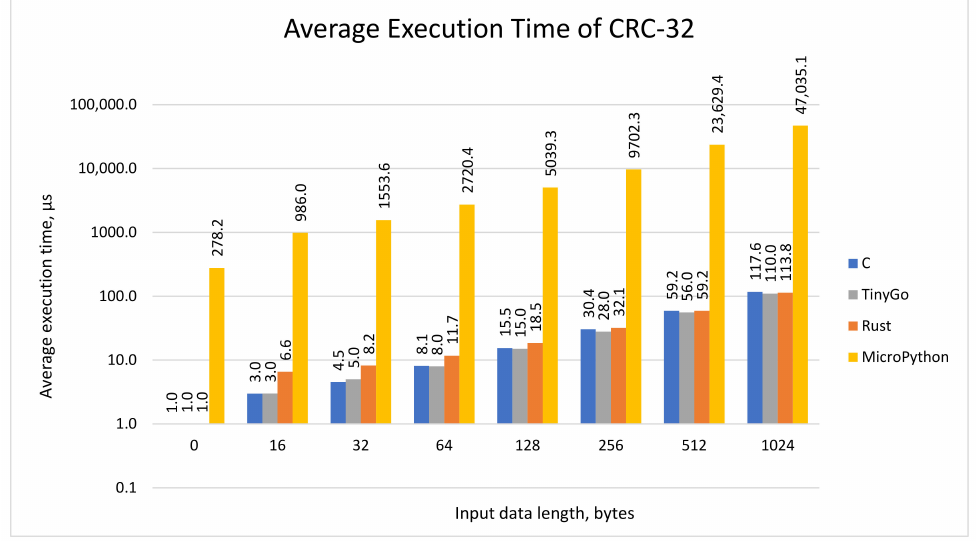
Figure 5. Average execution times of the CRC-32 algorithm (please note the logarithmic time